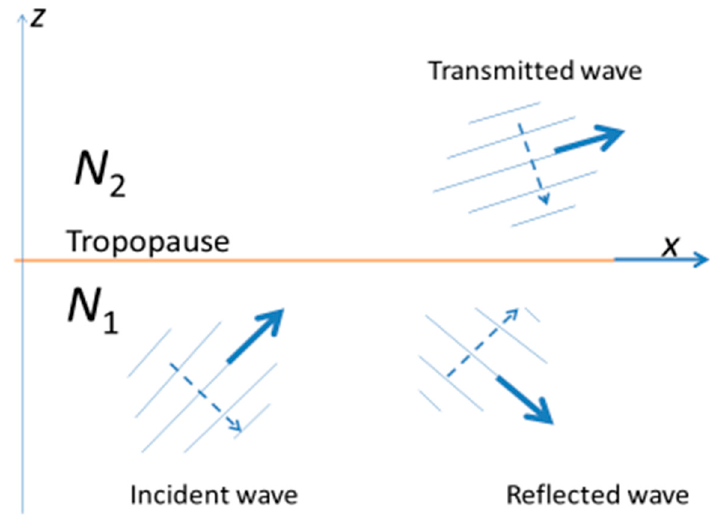
Figure 3. Schematic diagram of a wave packet with a dominant frequency ω , incident from below on the tropopause (represented as a discontinuity in N ). The thick arrow denotes the direction of the group velocity and motion of the wave packet, and the dashed arrow denotes the direction of the phase velocity. The impact of the wave packet on the tropopause results in a reflected wave of smaller amplitude, and a transmitted wave, also of smaller amplitude, with overall energy conserved.